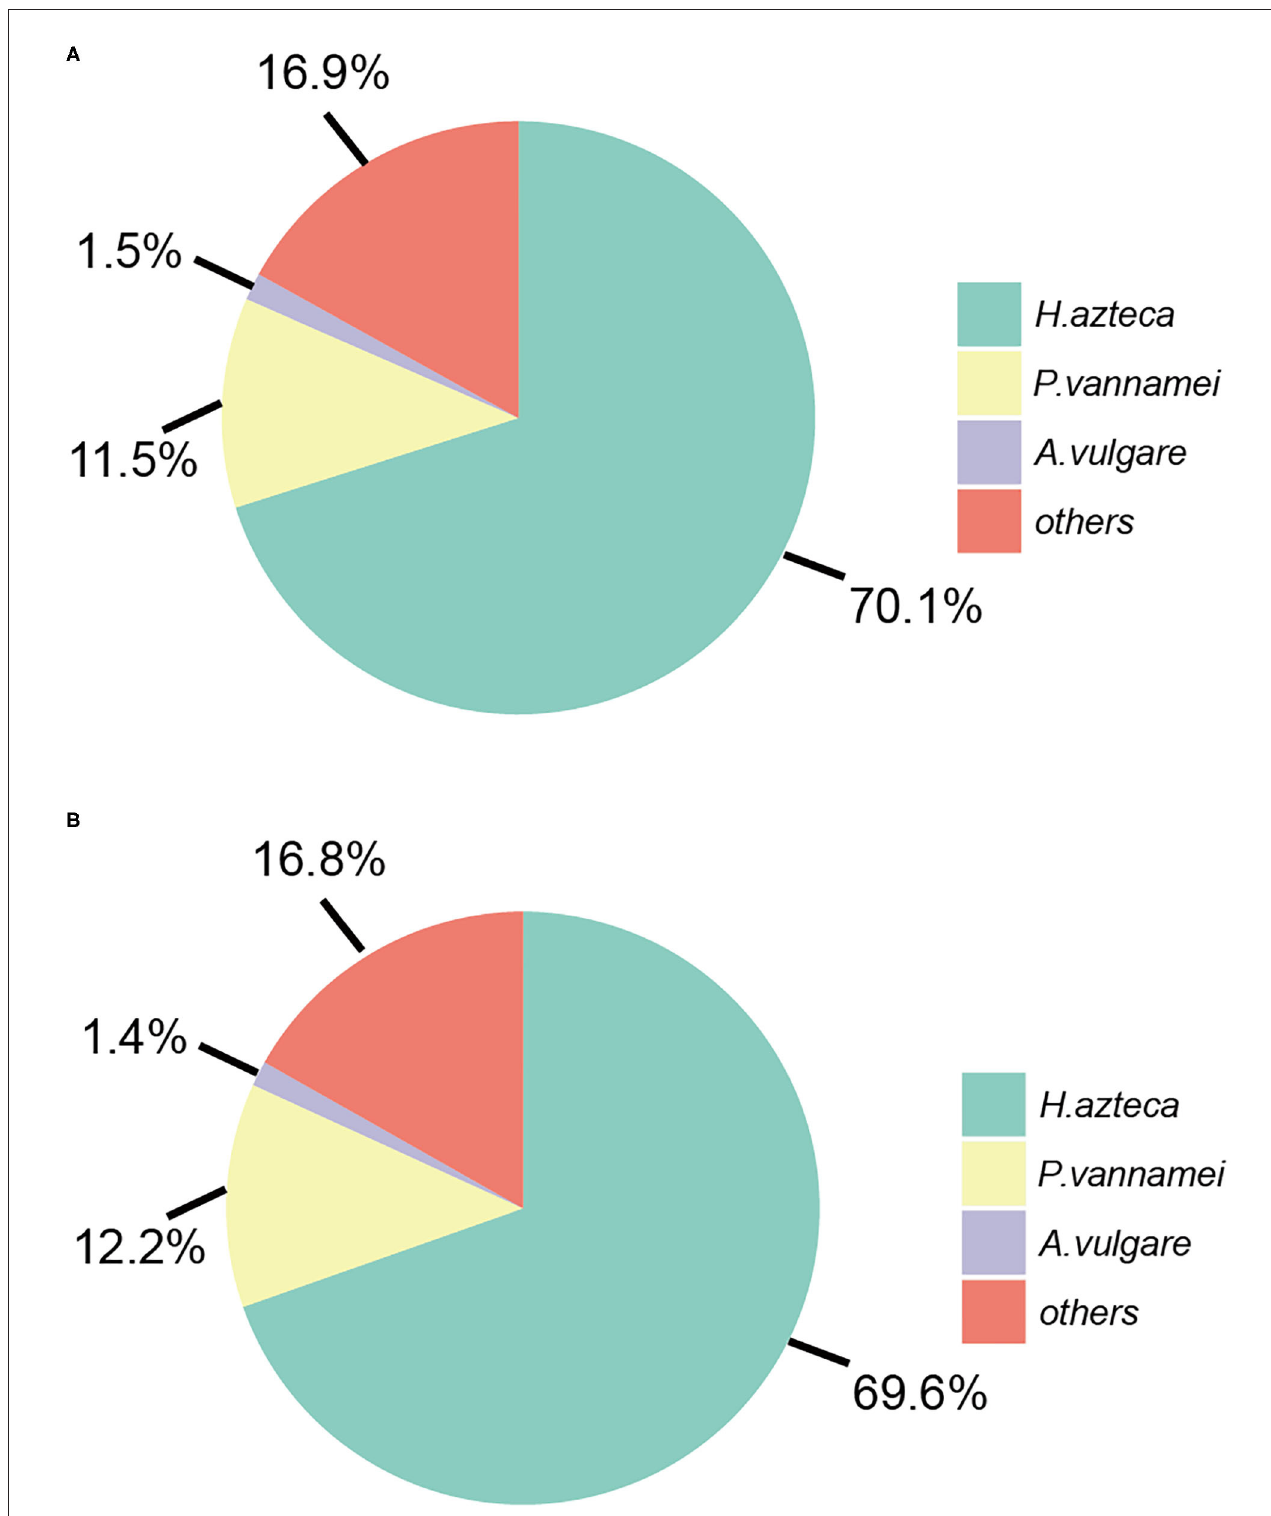
FIGURE 2 | The distributions of the hit species for A. gigantea (A) and B. schellenbergi (B) based on BLASTP against non-redundant (Nr) databases.